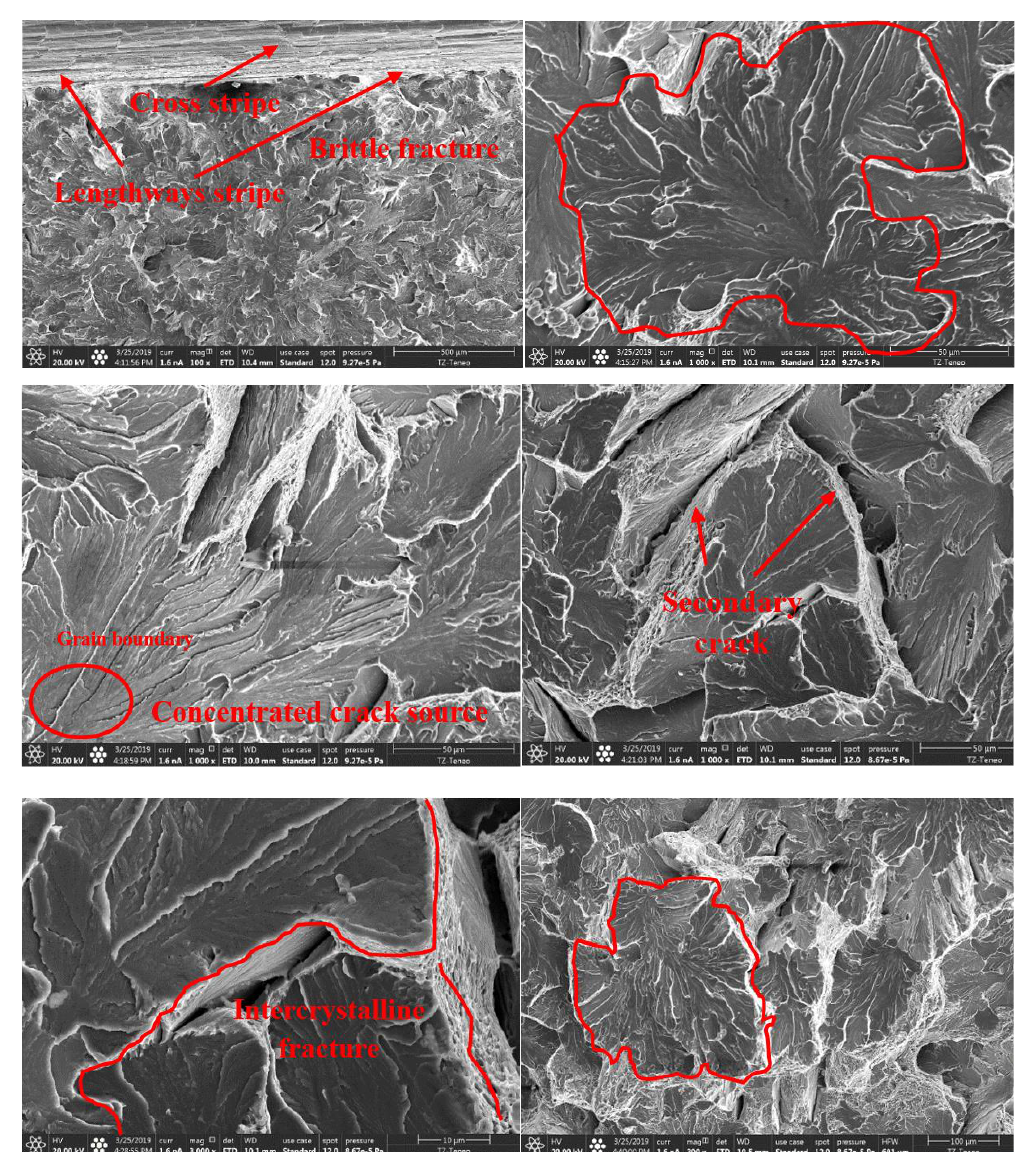
Figure 7. Fracture morphology of sample 1#.